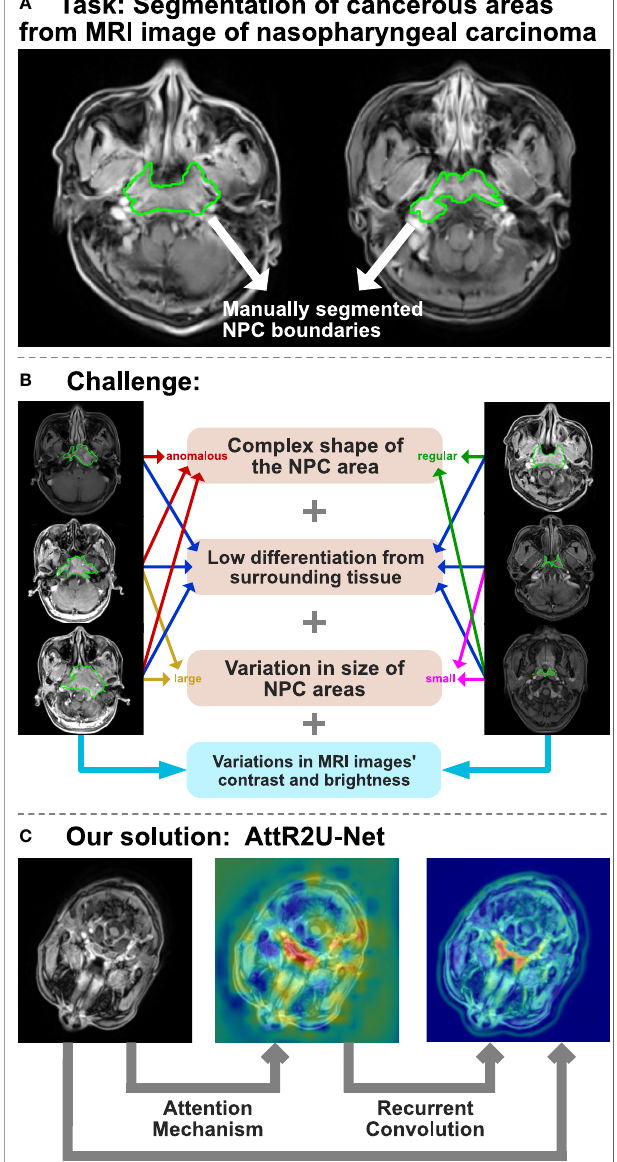
FIGURE 1 | The overview of AttR2U-Net model for automatic segmentation of nasopharyngeal carcinoma. (A) The task of the AttR2U-Net model. (B) The challenges of segmentation arise from two main aspects, in which orange represents NPC internal causes and blue represents external cause. (C) The four main mechanisms of our solution: attention mechanism to localize NPC accurately, recurrent convolution to extract boundary details precisely, residual connection to build a deeper and more ef fi cient model, and normalization to reduce the variations in MRI